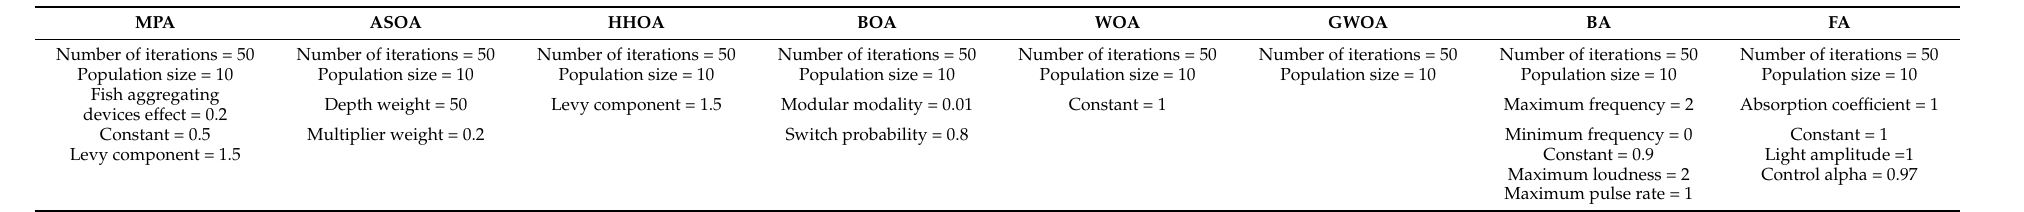
Table 2. Parameters for each algorithm.